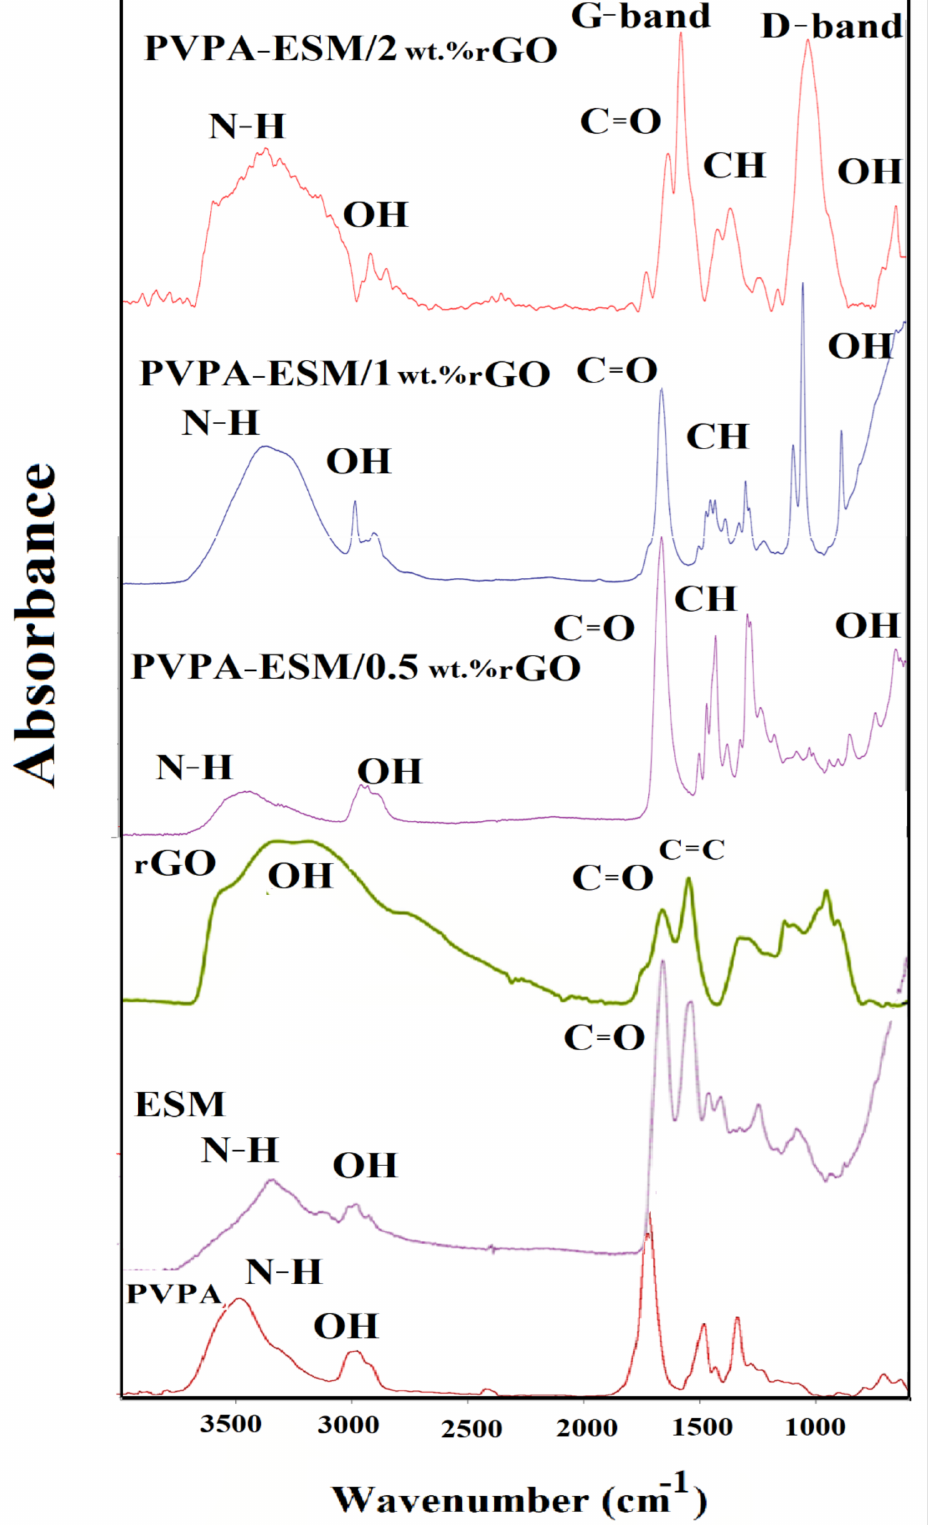
Figure 5. FTIR spectrum of the, PVPA, ESM, rGO, and PVPA–ESM/x wt.% rGO nanofibers with various rGO concentrations (x = 0, 0.5, 1 and 2